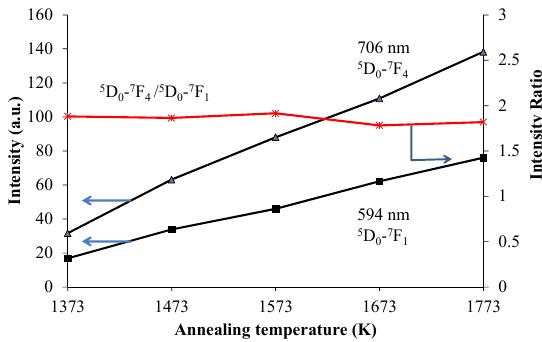
Figure 2. Emission and excitation spectra of (Ca 1.95 Eu 3+0.02 □ 0.03 )(Si 0.94 P 0.06 )O 4+ δ annealed at 1373 K, 1573 K, and 1773 K.